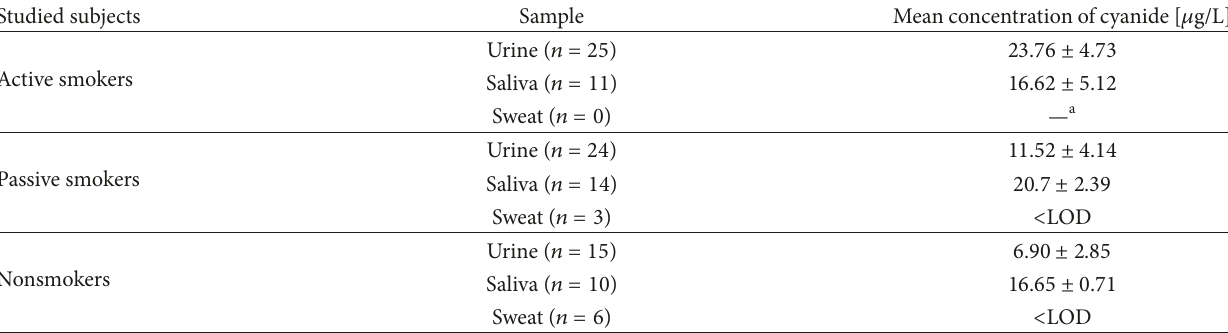
Table 2: Comparison of the results of cyanide in biological samples.